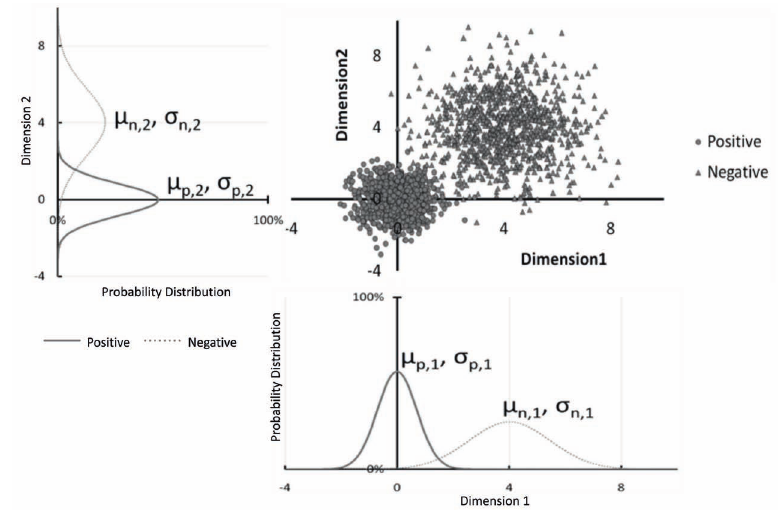
Figure 1. NormalBoost